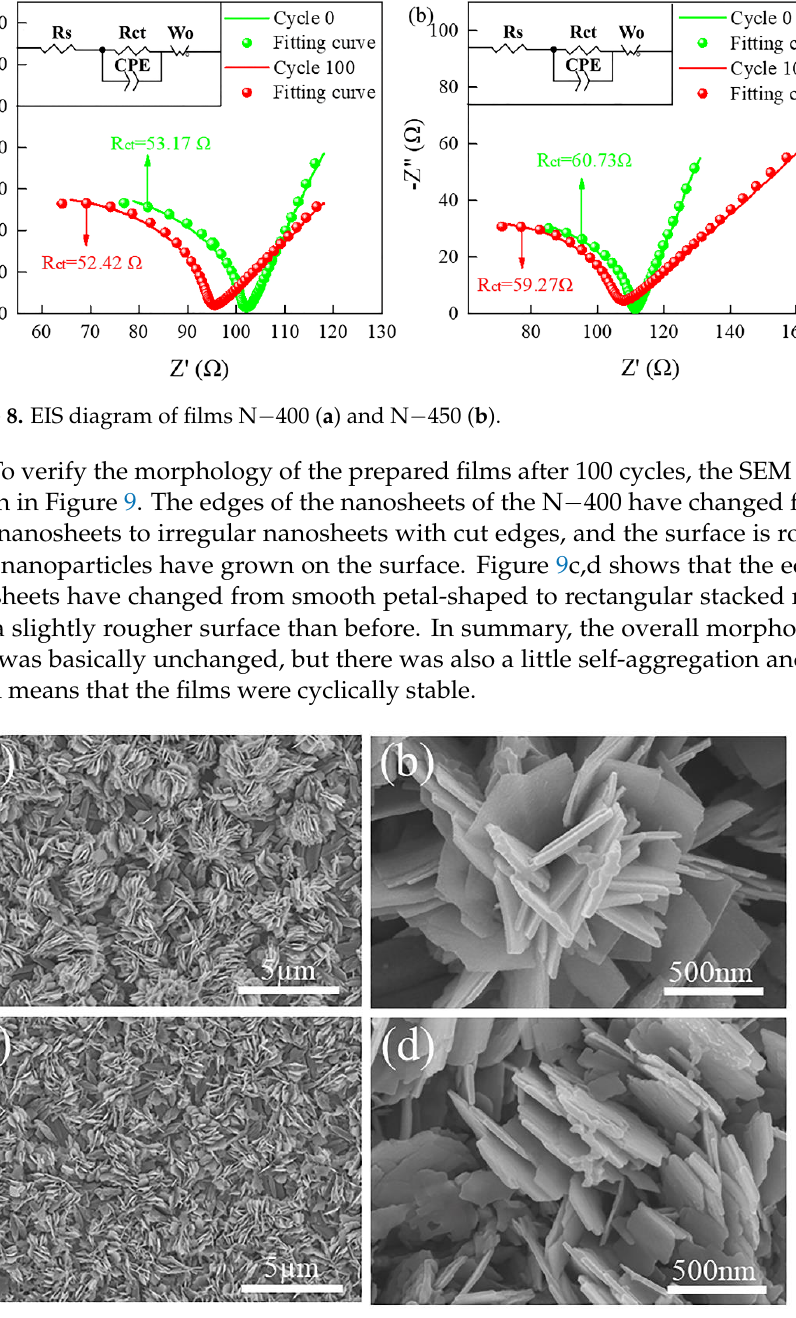
Figure 9. SEM images after 100 CV cycles of the films: N − 400 ( a , b ); N − 450 ( c , d ).